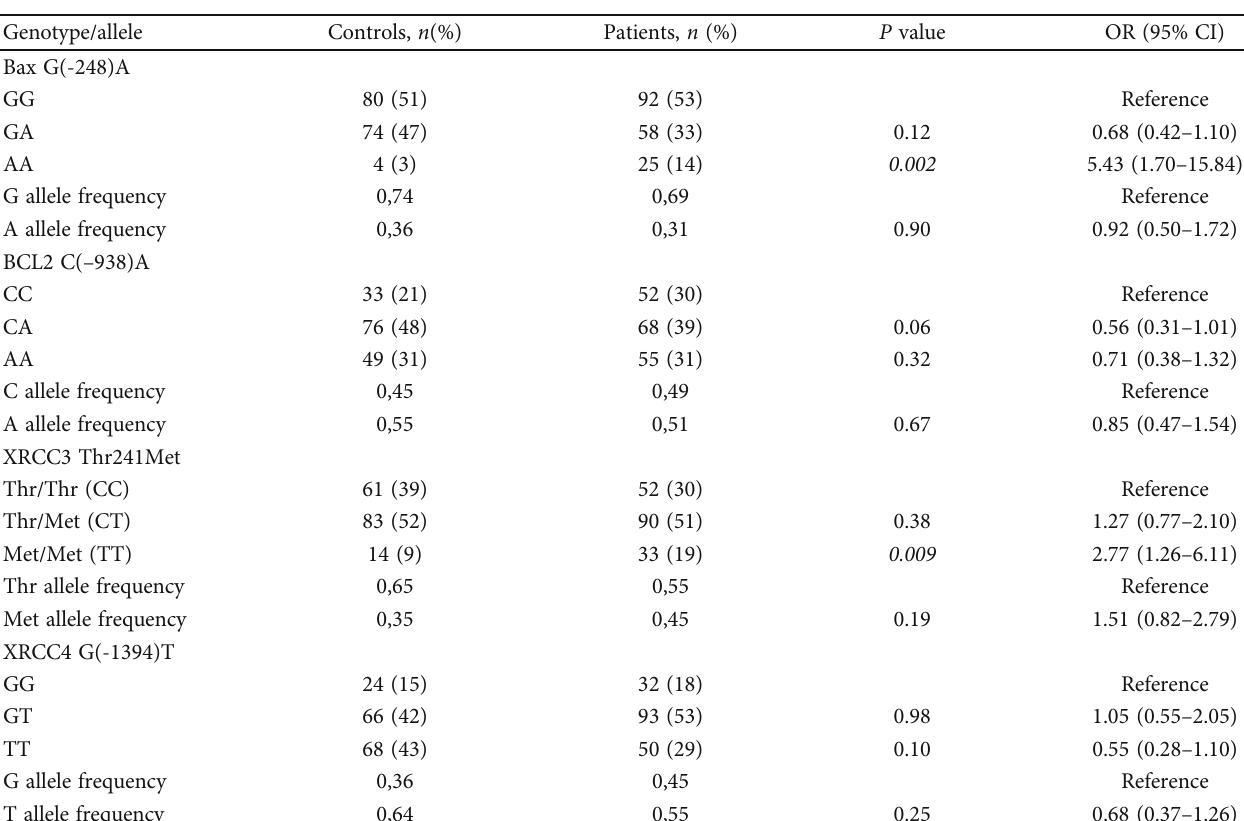
Table 4: Distribution of XRCC3 Thr241Met, XRCC4 G( ‐ 1394) T, Bax G(-248) A, and BCL2 C( ‐ 938) A genotypes among the controls and